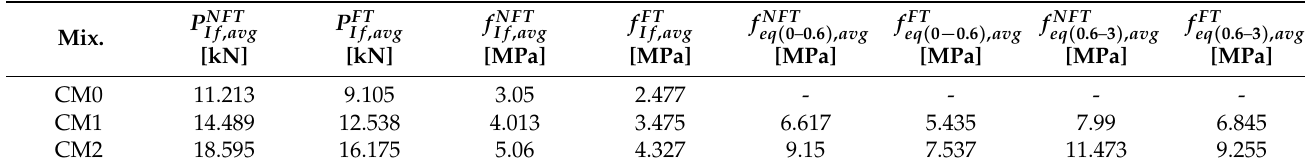
Table 1. The average values of the first crack load, P lf , of the first crack strengths, f ( If,avg ) , and of the equivalent postcracking strengths, f ( eq (0–0.6), avg ) and f ( eq (0.6–3), avg ) , before (NFT) and after the freeze–thaw cycles (FT) for each type of HPFRC mixture (CM0, CM1, and CM2).